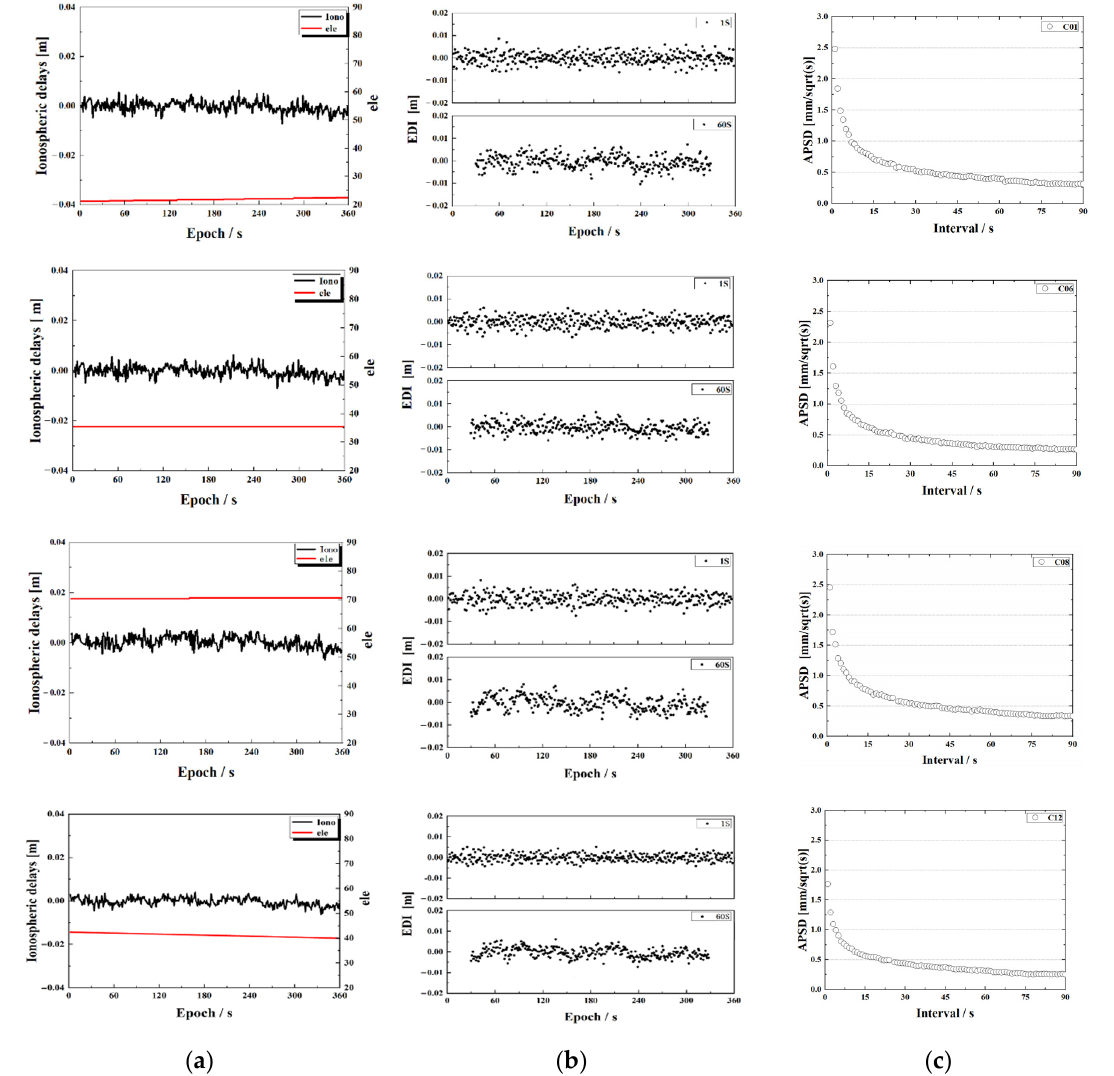
Figure 1. Time series of satellite ionospheric delays ( a ), the EDI at a differential interval of 1 s and 60 s ( b ), and APSD obtained at a different differential interval ( c ) for satellite C01, C06, C08 and C12 (from top to bottom) of the zero-baseline. The sampling rate of the observations is 1 s.